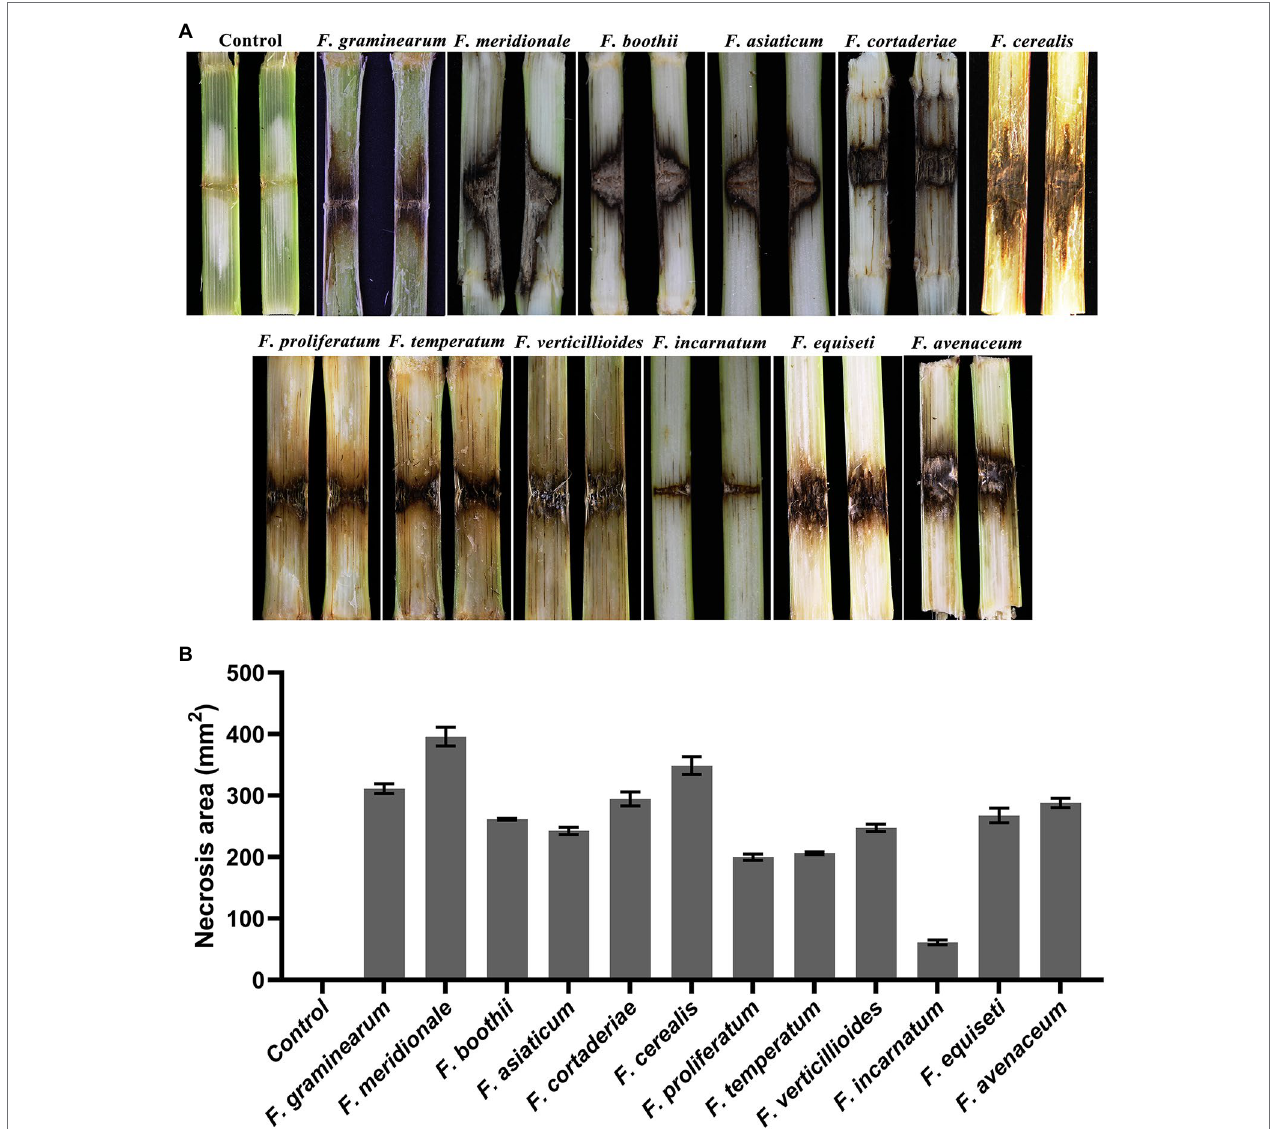
FIGURE 5 | Symptoms on maize stalks inoculated with representative Fusarium isolates. (A) Symptoms of maize stalks inoculated with representative Fusarium isolate at 7 dpi. No symptoms were observed in the control plants. (B) Statistical analysis of necrotic areas around the insertion point inoculated with representative Fusarium isolates at 7 dpi. The longitudinal brown infected areas were used to evaluate the virulence of each identified Fusarium species. Each assay was performed on three independent biological